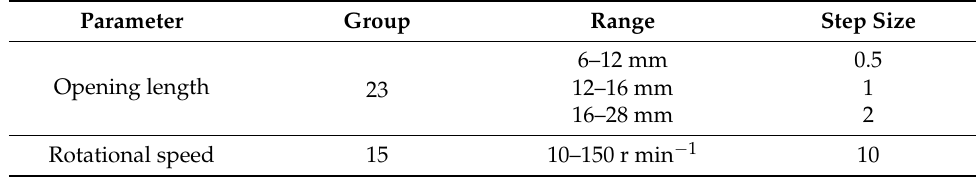
Table 1. Parameters of the bench